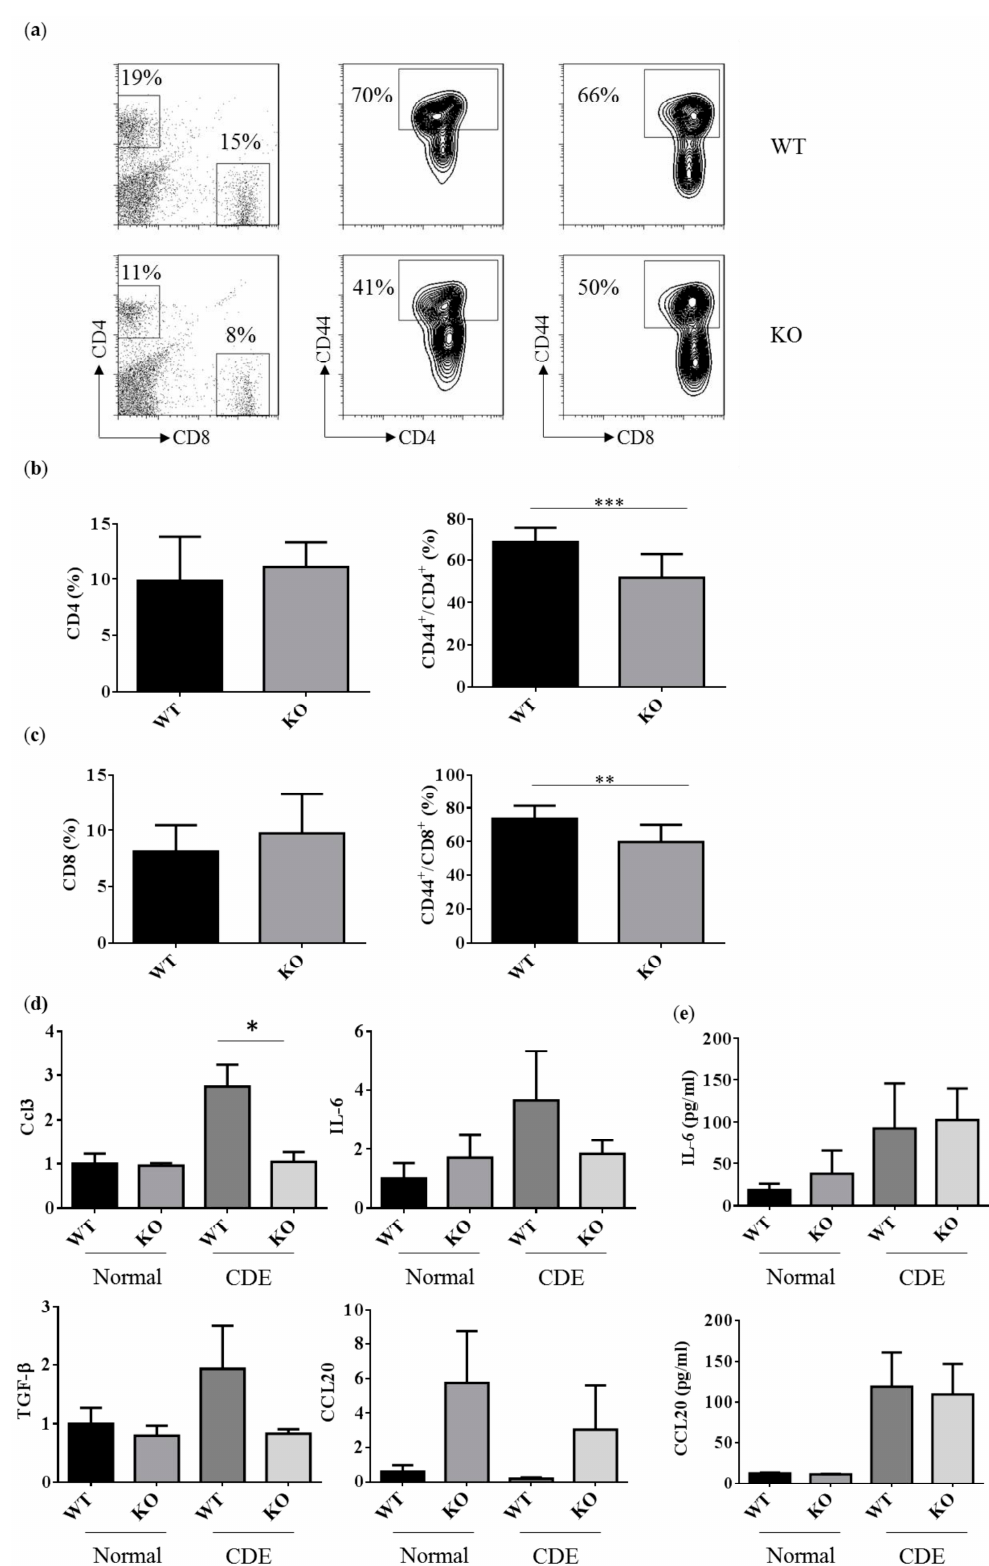
Figure 5. Reduced activated T cells in Erk2 − / − (KO) upon the CDE diet treatment. ( a ) hepatic lymphocytes from WT and Erk2 − / − (KO) livers were stained for T cells (CD4 or CD8) and activated markers (CD44). The percentages of CD4, CD8, CD44 + / CD4 + and CD44 + / CD8 + T cells were shown in representative WT and Erk2 − / − (KO) liver; ( b ) The percentages of CD4 T cells and CD44 + / CD4 + T